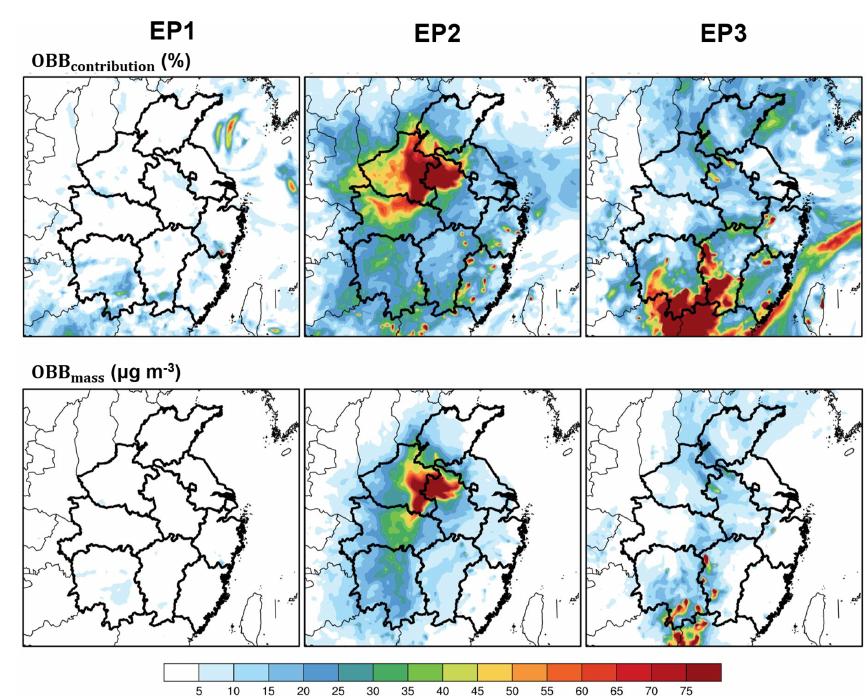
Figure 9. Spatial distributions of OBB mass and OBB contribution during EP1, EP2, and EP3. The maps were created by NCAR Command Language (NCL) (http://www.ncl.ucar.edu/, last access: 19 December